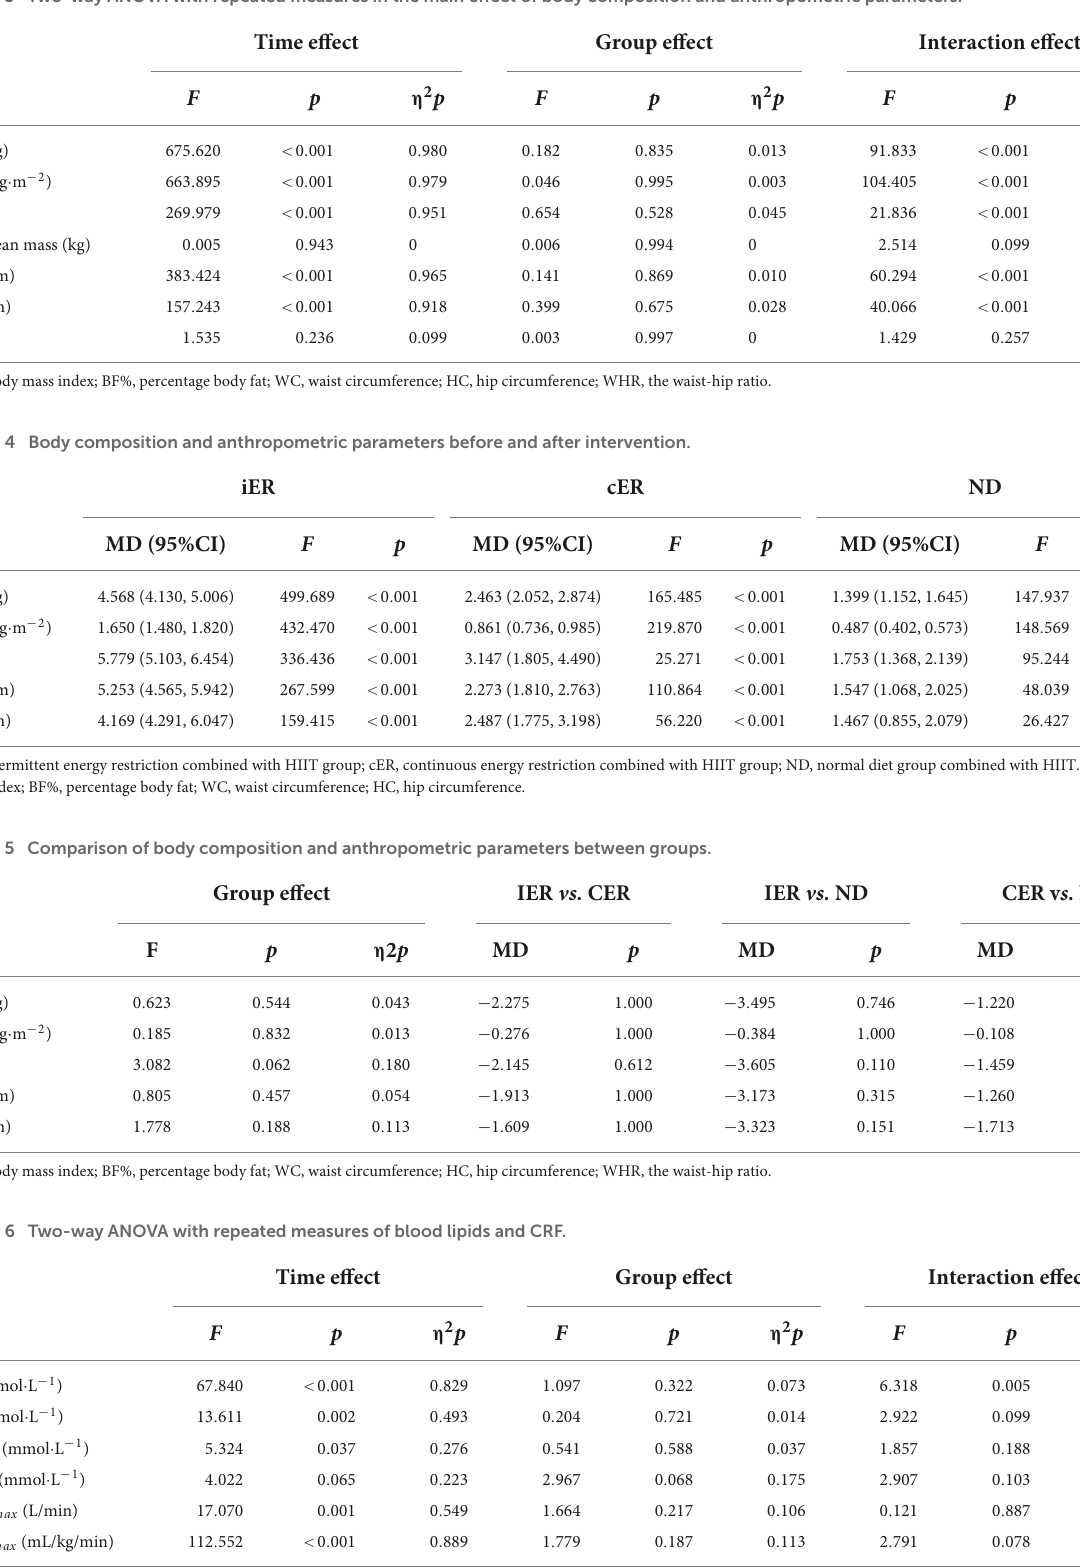
TABLE 3 Two-way ANOVA with repeated measures in the main effect of body composition and anthropometric parameters.